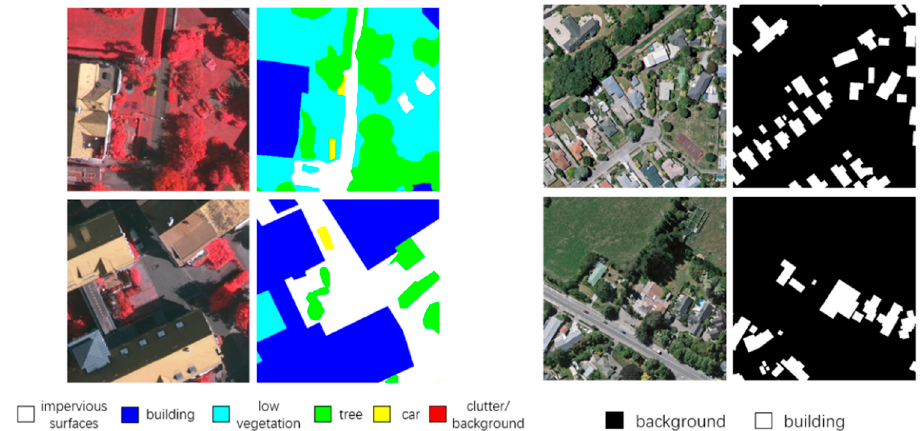
Figure 6. Example images and labels of ISPRS Vaihingen ( left ) and WHU Building ( right ) datasets.